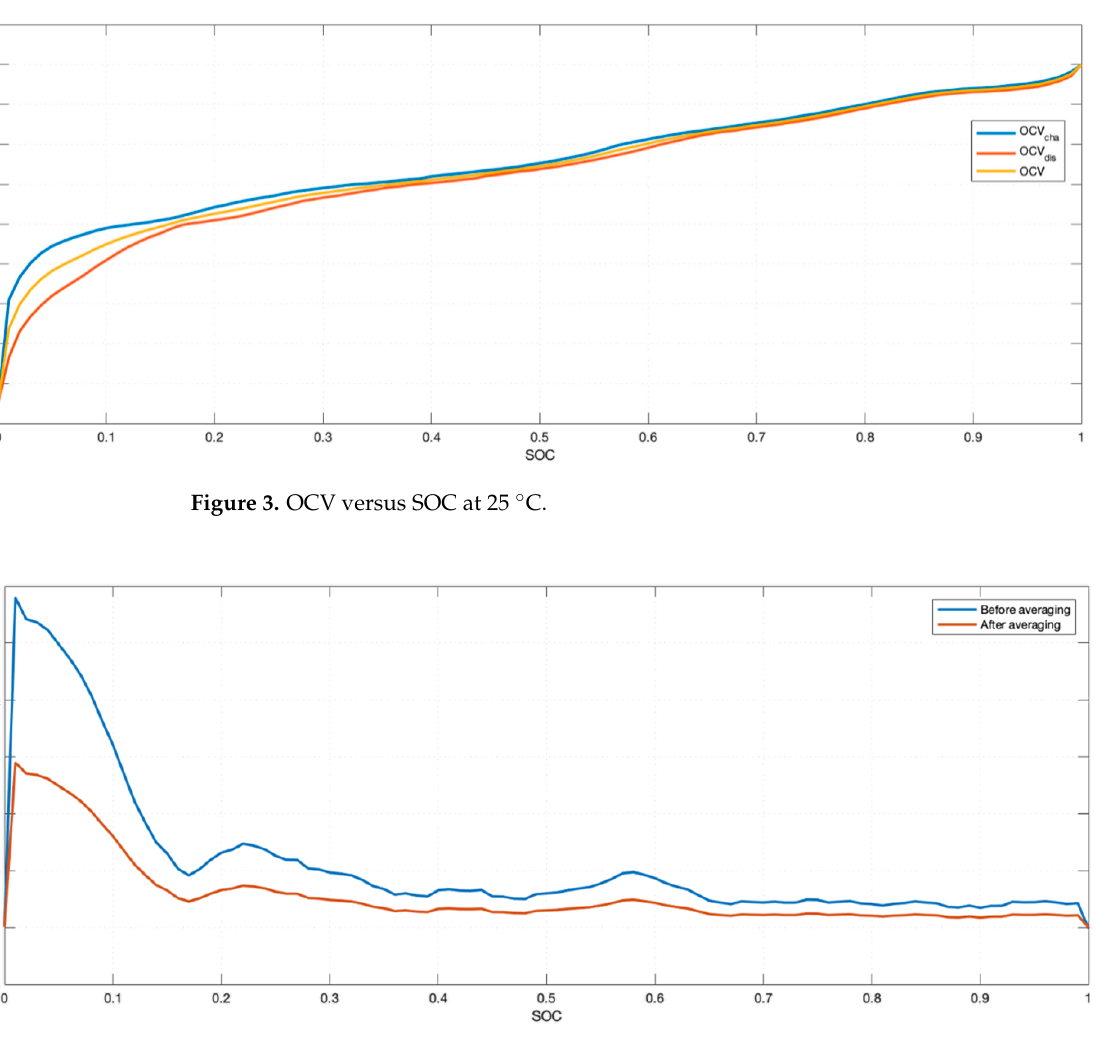
Figure 4. OCV difference versus SOC.